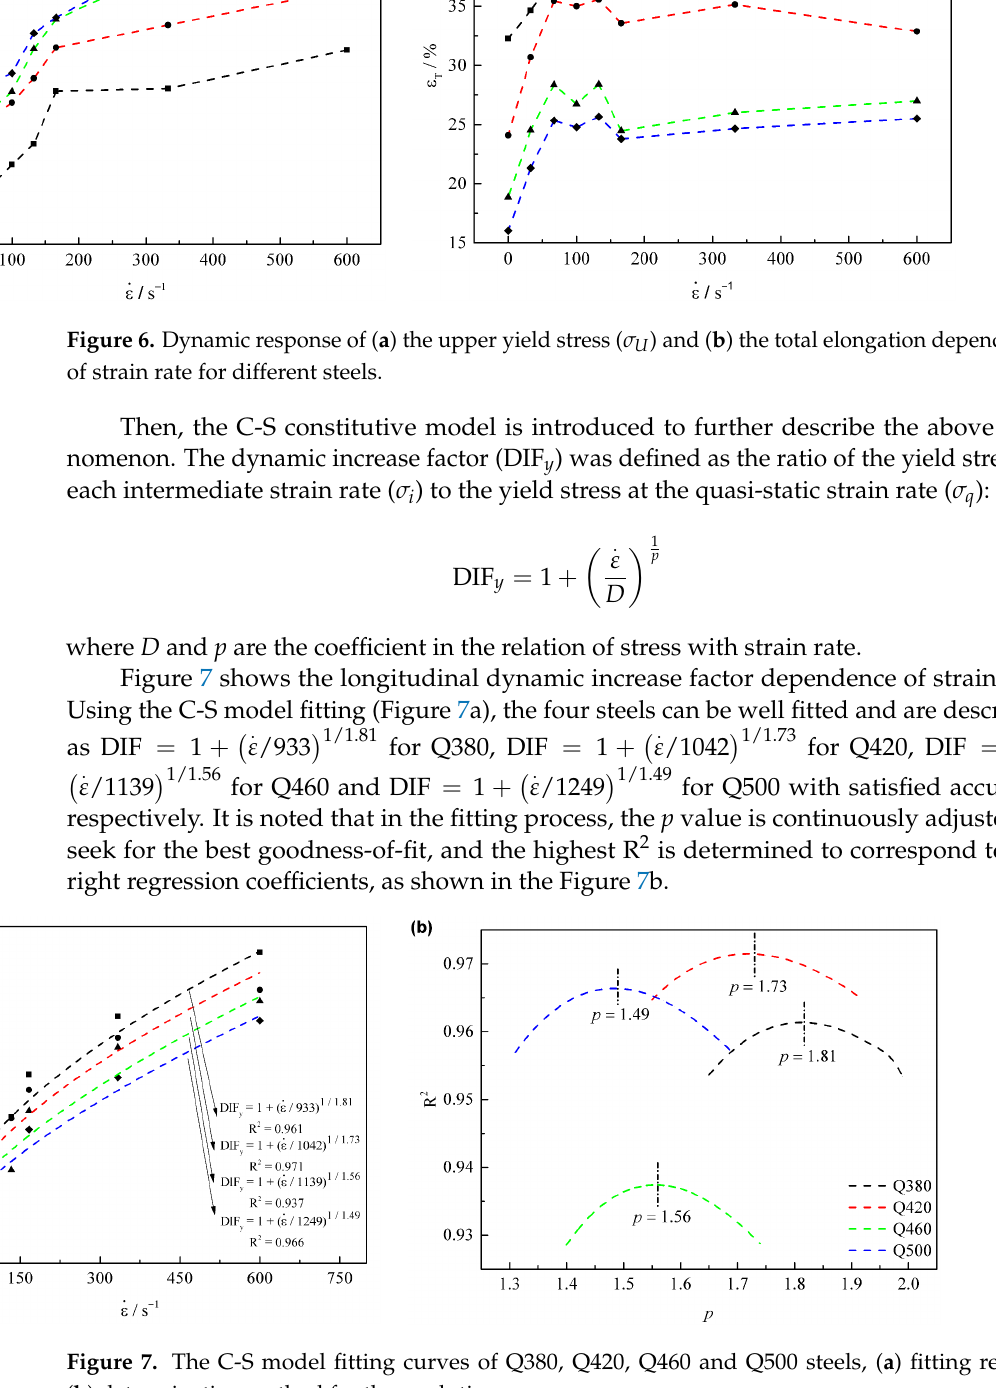
Figure 8. The variation of essential parameters in C - S model, ( a ) D and p dependence of steel grade 𝜎 (cid:2917) , where the two arrows are pointed to two Y-axes of D and p ， respectively, and ( b ) the p dependence of the Hall-Petch coefficient 𝑘 (cid:3009)(cid:3017) . The graphs for the linear regression analysis based on the above data depending on steel grade are shown Figure 8a; the essential parameter D is proportional while p is in- versely proportional to the steel grade, showing an amazingly strong contrast. By comparing the parameter p in C-S model, we can see that there is a certain rela- tionship 𝑝 = 693.97/𝑘 (cid:3009)(cid:3017) between them, as shown in Figure 8b. Since the Hall–Petch equation is very essential for materials, and the 𝑘 (cid:3009)(cid:3017) is easily available in the literatures, the C-S model can be replaced as: 𝐷𝐼𝐹 (cid:3052) = 1 + (𝜀(cid:4662) 𝐷 ) (cid:3012) (cid:3257)(cid:3265) (cid:2874)(cid:2875)(cid:2871).(cid:2875)(cid:2877)